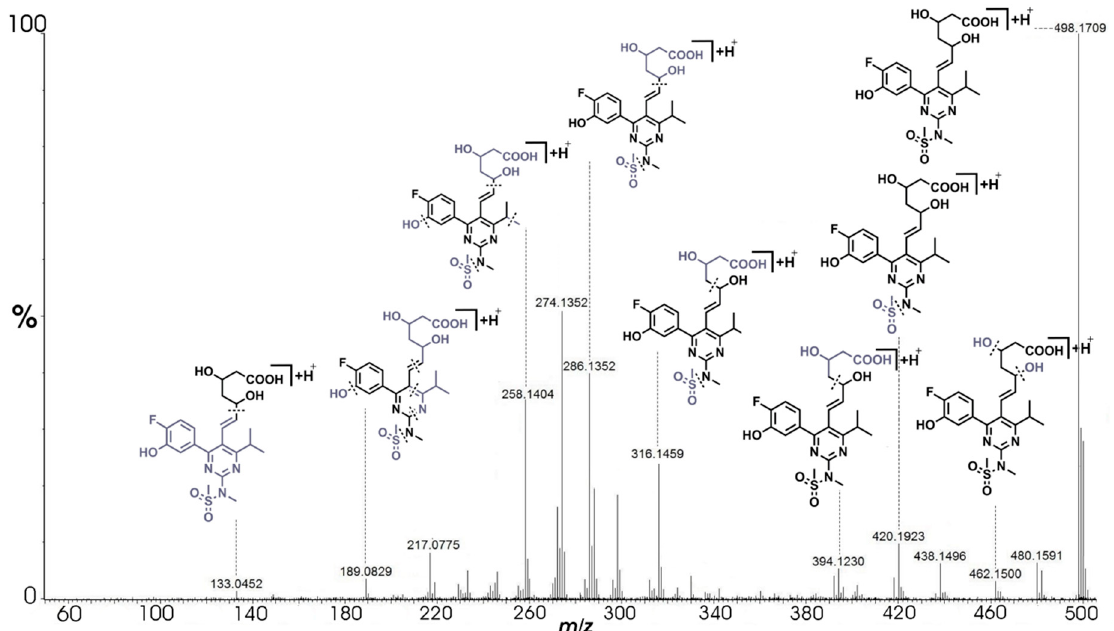
Figure 6. Fragmentation MS/MS spectra of product C.1 [M + H] + ion (precursor ion mass m/z 498.1709) obtained by using collision energy of 25 V.